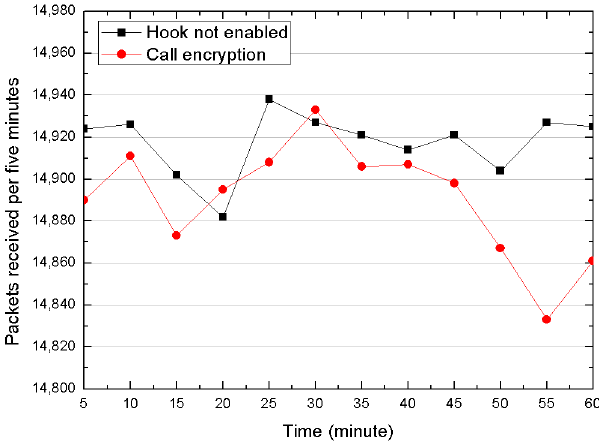
Figure 6. Packet traffic comparison per five minutes.